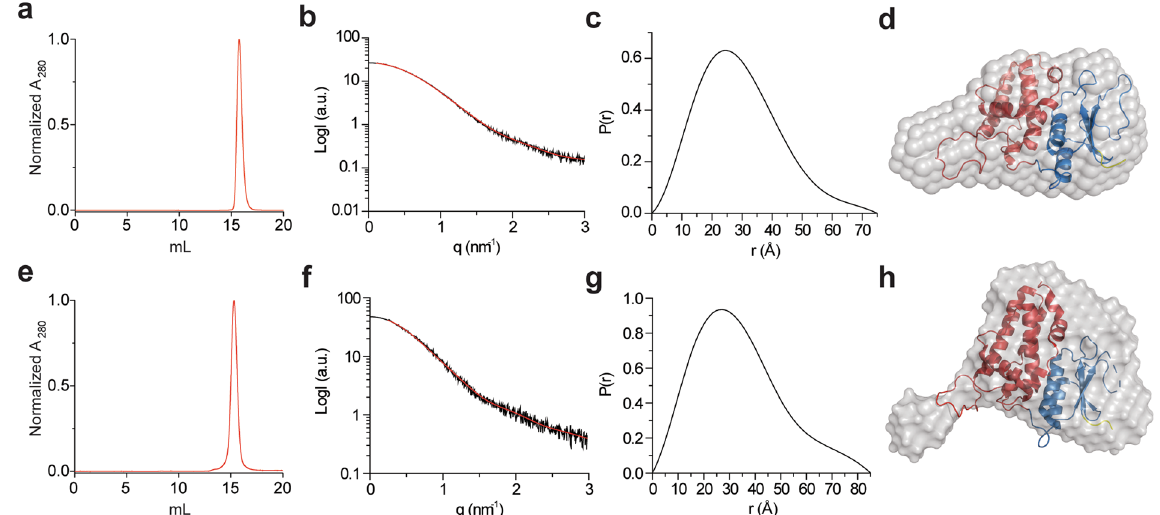
Figure 4. Solution properties of mCLIC6. ( a ) Size exclusion chromatography elution profile of mCLIC6-WT. ( b ) Experimental SAXS curves of mCLIC6-WT (black line) along with the fit obtained by GNOM (red line) used for ab-initio modelling. ( c ) Paired-distance distribution function of mCLIC6-WT determined using GNOM. ( d ) Ab-initio model of CLIC6-WT in solution (grey surface). ( e ) Size exclusion chromatography elution profile of mCLIC6-Q383A. ( f ) Experimental SAXS curves of mCLIC6-Q383A (black line) along with the fit obtained by GNOM (red line) used for ab-initio modelling. ( c ) Paired-distance distribution function of mCLIC6-Q383A determined using GNOM. ( d ) Ab initio model of CLIC6-Q383A in solution (grey surface). The structure of mCLIC6 was fit into the molecular envelopes using SUPCOMB. The TRX and α domains are presented as blue and red cartoons,